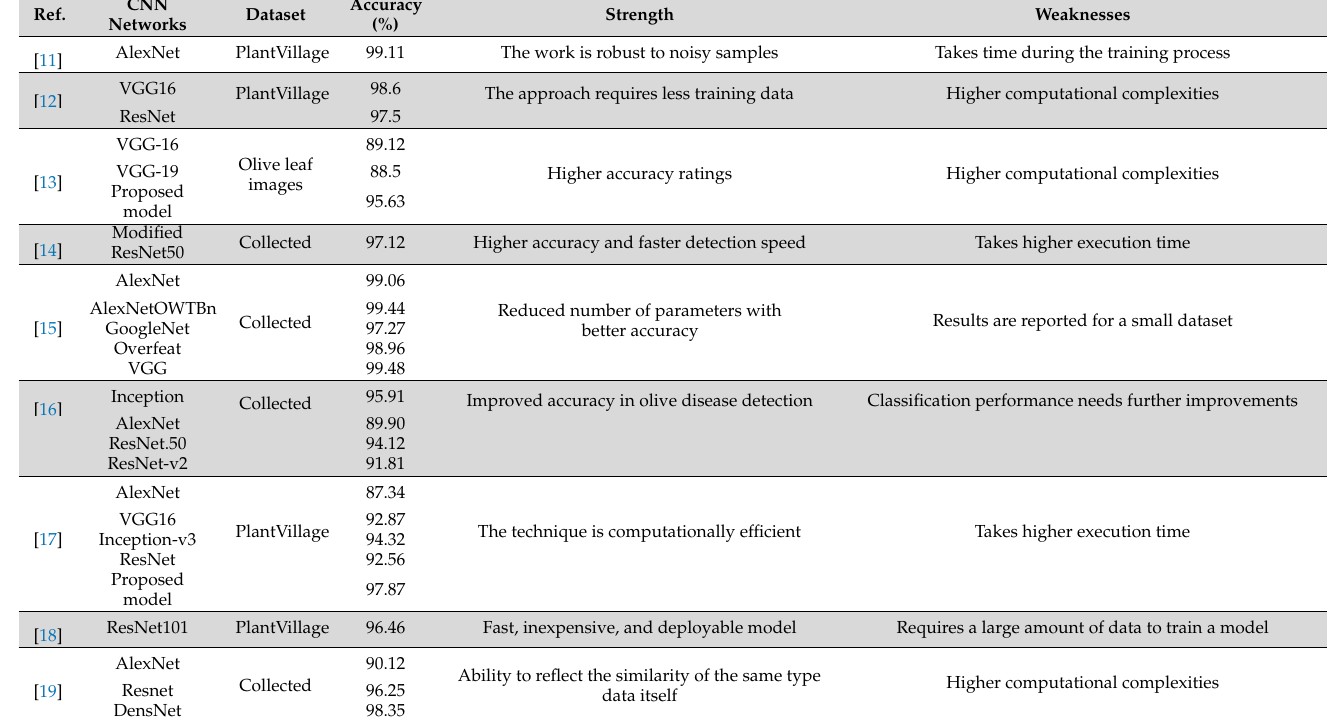
Table 1. A summary of related